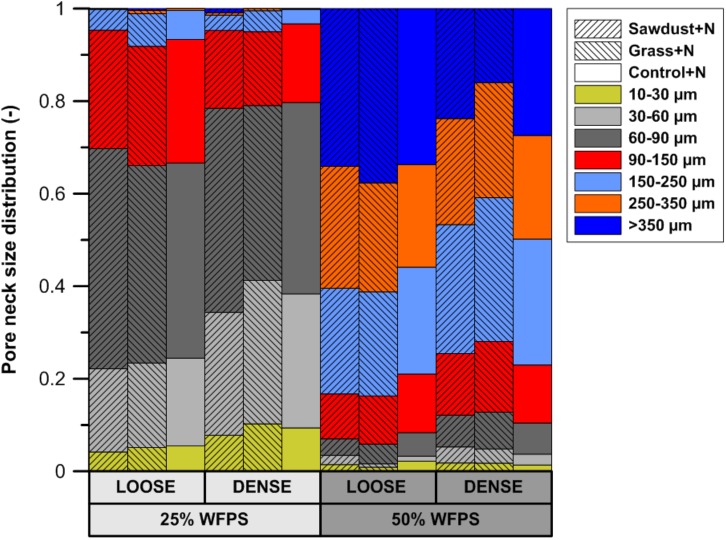
Subdivision of the X-ray μCT visible pore space volume at either 25 or 50% WFPS moisture level and with a ‘loose’ or ‘dense’ soil structure, into seven pore neck diameter classes (10–30, 30–60, 60–90, 90–150, 150–250, 250–350, and >350 μm).